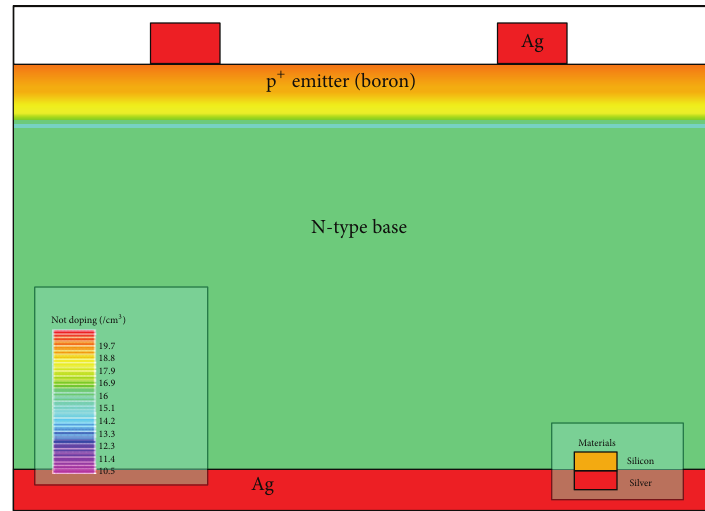
Figure 1: Schematic cross-section of boron-doped p + emitter for n-type silicon solar